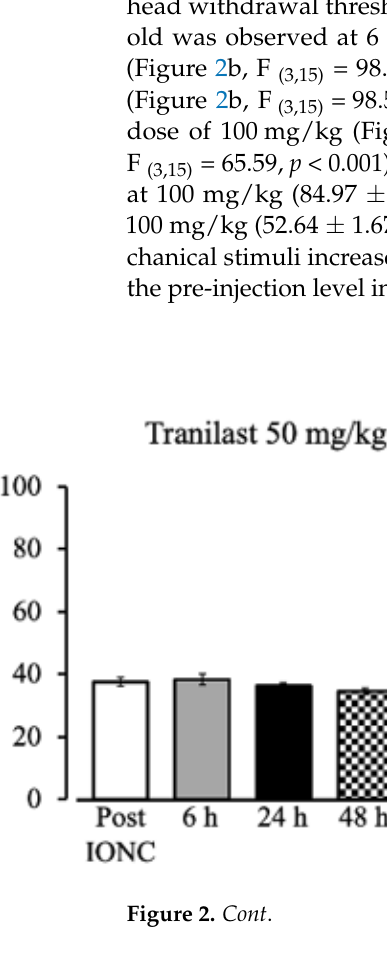
Figure 2. Head withdrawal threshold to mechanical stimuli after intraperitoneal injection of tra- nilast. ( a ) Tranilast 50 mg/kg showed no changes in head withdrawal threshold to mechanical stim- uli. ( b ) Tranilast 75 mg/kg dosage increased the threshold to mechanical stimuli at 6 h post injection. ( c ) Tranilast 100 mg/kg and ( d ) tranilast 200 mg/kg dosages increased the threshold to mechanical stimuli at 6 and 24 h in comparison to the pain model threshold. The head withdrawal thresholds are represented as mean ± SEM. n = 6 per group. ** p < 0.01, *** p < 0.001, repeated measures analysis of variance followed by Tukey’s HSD test. 2.3. The Effects of Tranilast in Regard to Mechanical Stimuli Post IONC Lasted Up to 24 h in Comparison to Carbamazepine The head withdrawal threshold after intraperitoneal injection of tranilast (50, 75, 100 and 200 mg/kg), carbamazepine (30 mg/kg) or saline was recorded for three consecutive cycles (Figure 3a,b). An increased head withdrawal threshold on the ipsilateral side of the IONC was observed in the tranilast and carbamazepine groups at 6 h post-injection (Fig- ure 3a, (F (6,35) = 214.67), p < 0.001). The tranilast 75 mg/kg (51.62 ± 2.19 g) ( p = 0.002), tranilast 100 mg/kg (83.13 ± 0.88 g) ( p < 0.001), tranilast 200 mg/kg (85.56 ± 1.09 g) ( p < 0.001) and carbamazepine groups (60.93 ± 0.72 g) ( p < 0.001) showed increased tolerance to mechan- ical stimuli, while tranilast 50 mg/kg (37.07 ± 1.72 g) ( p = 0.995) did not show any effect when compared to the saline group. At 24 h, the effect of the drug continued to last and showed an increased head withdrawal threshold on the ipsilateral side of the IONC in the tranilast group only (Figure 3a, F (6,35) = 249.62), p < 0.001). Tranilast 100 mg/kg (55.48 ± 0.60 g) ( p < 0.001) and 200 mg/kg (59.34 ± 0.85 g) ( p < 0.001) showed increased tolerance to mechanical stimuli, while carbamazepine ( p = 0.821), 75 mg/kg (34.34 ± 0.99 g) ( p = 0.970) and 50 mg/kg (36.33 ± 0.92 g) ( p = 1.00) did not show any effect when compared to the